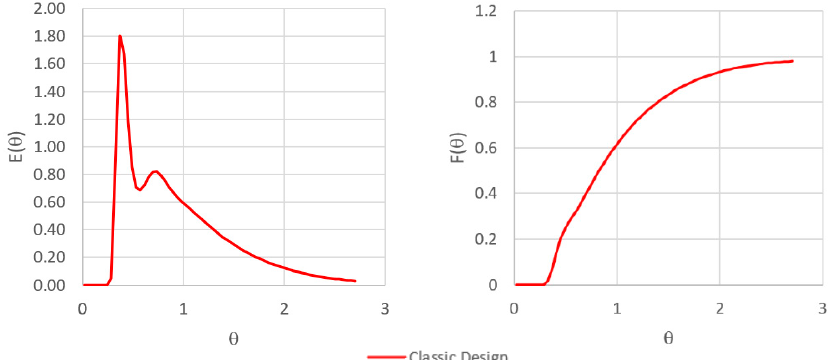
Figure 7. E( θ ) and F( θ ) plots (Equations (7) and (8)) obtained from tracer simulations for classic contact tank.